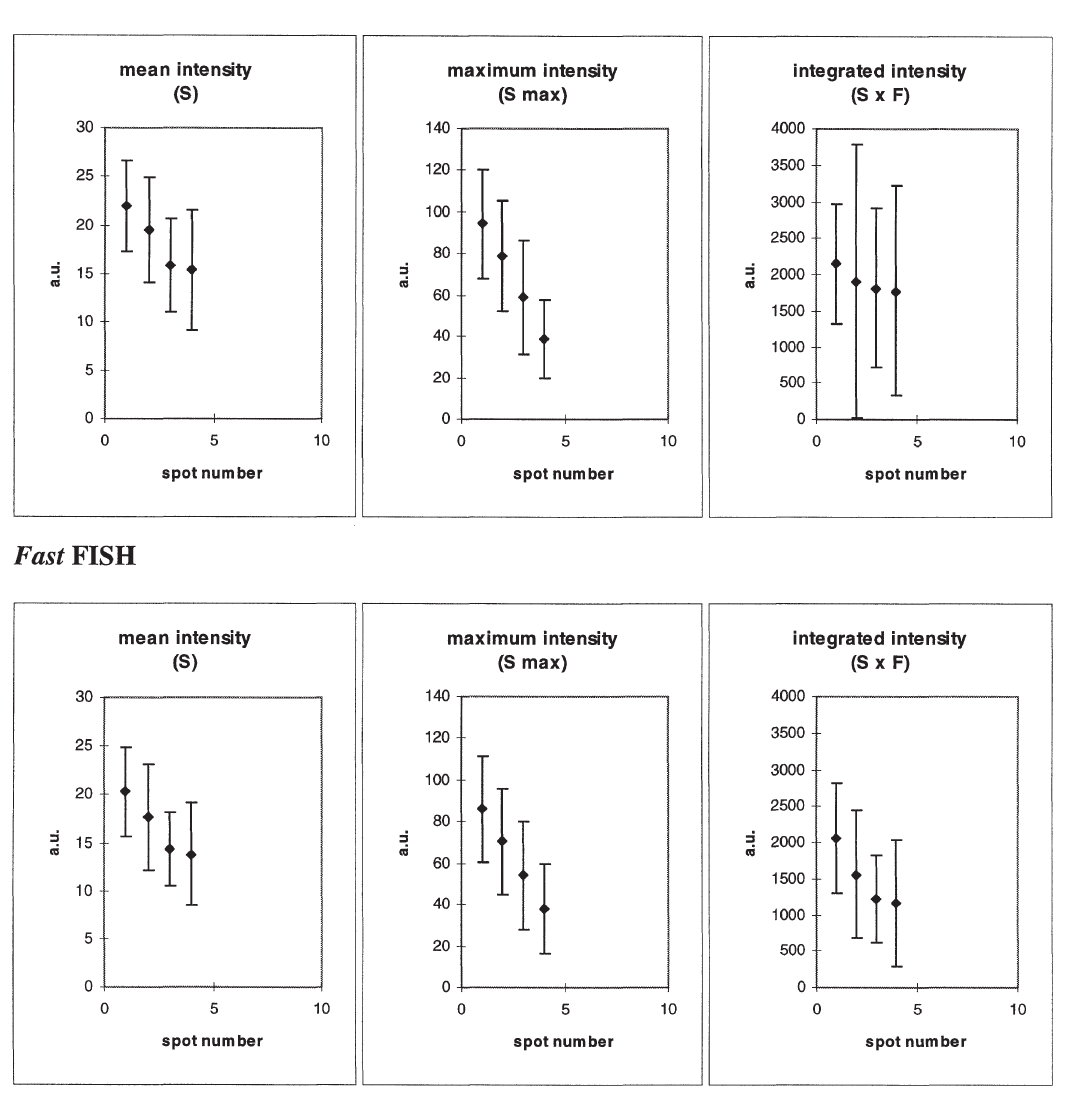
Fig. 3. The classification parameters of labelling sites shown for standard and Fast -FISH for patient 8-2 (AML with tetra- somy 8). 132 cell nuclei (standard FISH) or 129 ( Fast -FISH), respectively, were evaluated. According to their brightness the spots of each nucleus were classified. The brightest, second brightest, third brightest, etc., spots were listed (abscissa) and averaged. The points represent the mean values with their standard